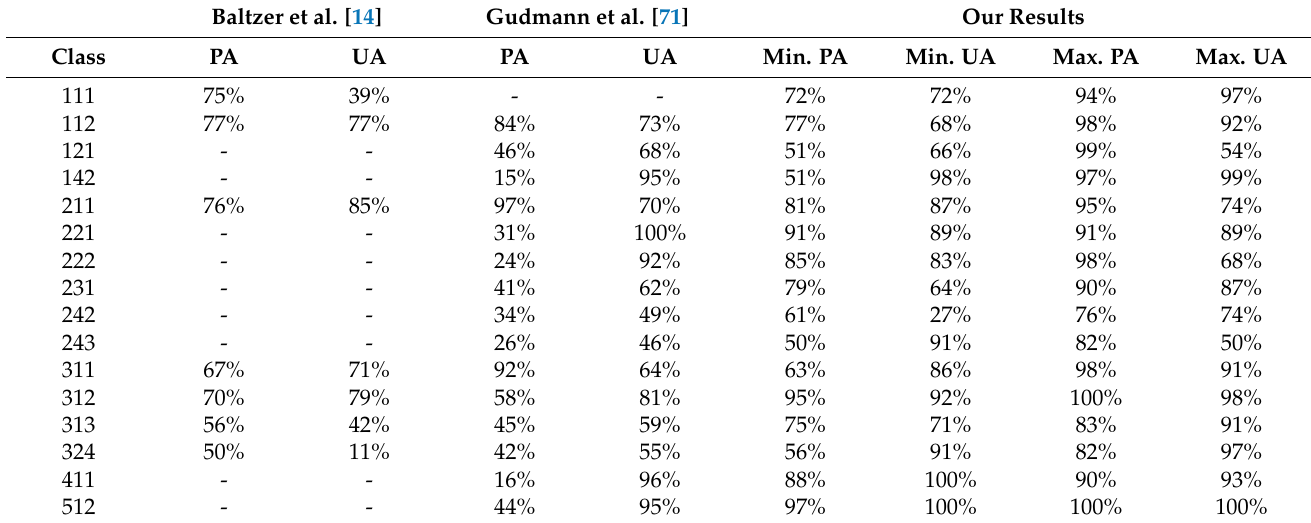
Table 14. Comparison of the obtained results by CLC classes with the literature. Baltzer et al.